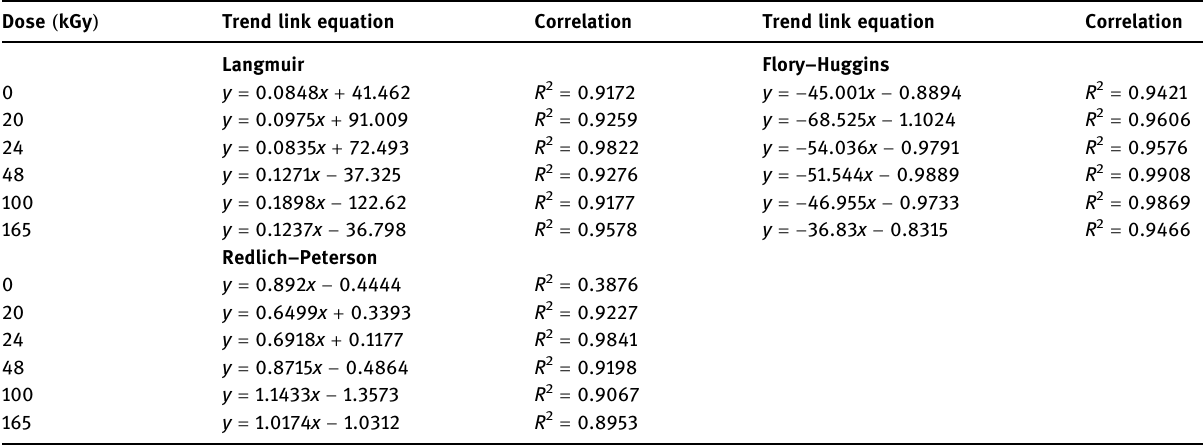
Table 4: The correlation equations determined graphically for Cu ( II ) based on the linearized equations of models presented in Table 3